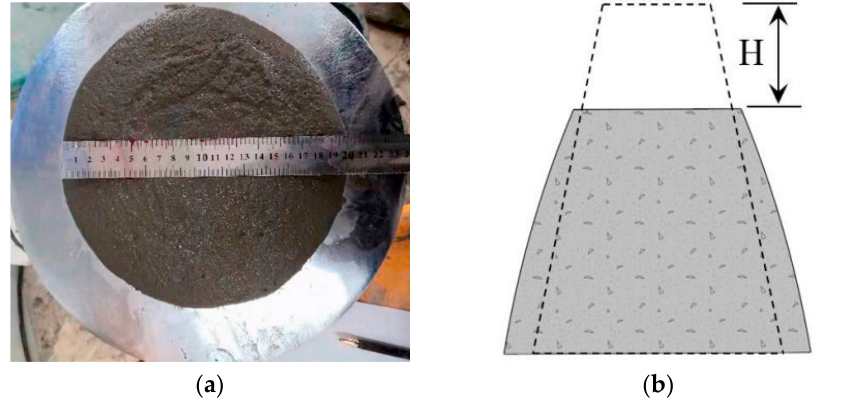
Figure 2. ( a ) Flowability experiment, ( b ) slump test.